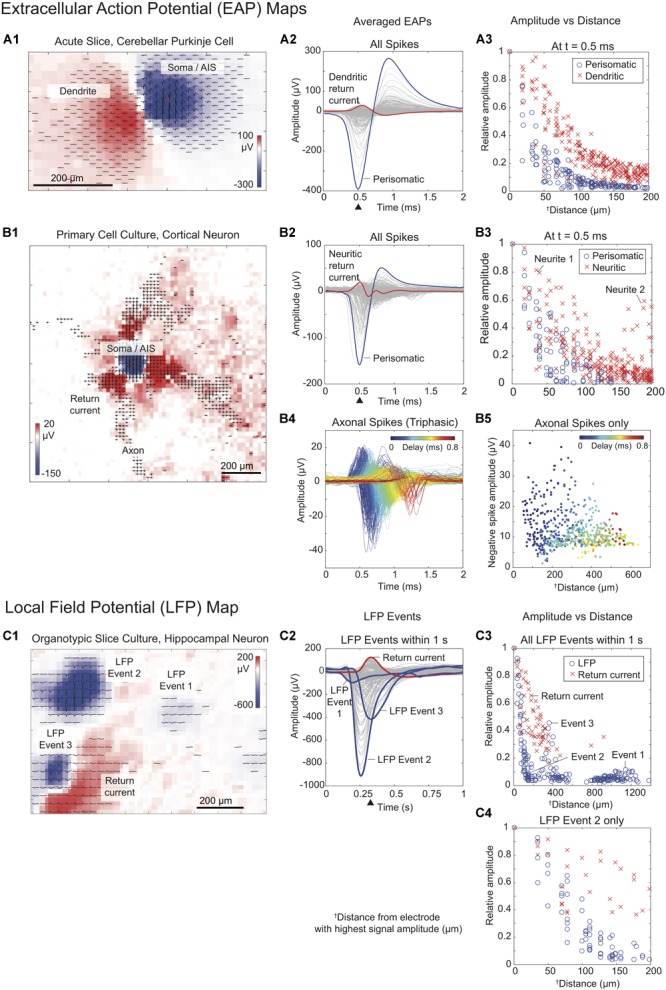
Signal sources. Extracellular action potentials (EAPs) generated by (A) a cerebellar Purkinje neuron from an acute-slice recording and (B) a cortical neuron from a dissociated cell culture recording. (A1,B1) Spatio-temporal features of extracellular action potentials (band-pass filter: 100–3000 Hz). Waveforms were averaged over 500 individual spikes. (A2,B2) Averaged EAP spike waveforms. Waveforms in blue indicate the signal with the largest negative spike amplitude (from electrodes marked with red squares in figure (A1,B1), while the waveforms in red show the return current signal with the largest positive amplitude during the spiking events. (A3,B3) Relative amplitudes of signals versus distance of the recording electrodes from the location of the electrode with the largest negative amplitude (normalization to the largest negative and positive signal amplitudes). Blue circles refer to the amplitude of the negative spikes originating from the perisomatic area (soma, axon initial segment or AIS). The amplitudes of the return currents during the EAP are shown as red x’s. (B4) Axonal spikes, comprising all triphasic spikes in (B2) detected after the occurrence of the largest negative spike. (B5) Amplitude of the largest negative signal of all axonal signals versus distance of the electrodes from the location of the electrode with the highest-amplitude negative spike. (C) Local field potentials recorded from an organotypic hippocampal slice culture. (C1) Spatio-temporal features of LFP events that occurred within 1 second at the CA3 and dentate gyrus areas of a hippocampal slice culture (band-pass filter: 1–10 Hz). (C2) LFP event waveforms and return currents. The largest return current signal is in red, while the three largest negative peaks indicating the LFP events at different time points are displayed in blue. (C3,C4) Relative amplitudes of recorded signals during all LFP events and during LFP event 2 (blue circles) and return current signals (red x’s) versus distance of the respective recording electrodes from the electrode featuring the highest-amplitude signals (normalization to the largest negative and positive signal amplitudes). The black triangles in (A2,B2,C2) mark the time points used for electrical mapping of the signal amplitudes recorded from all electrodes shown in (A1,B1,C1) (color scale: blue to red).